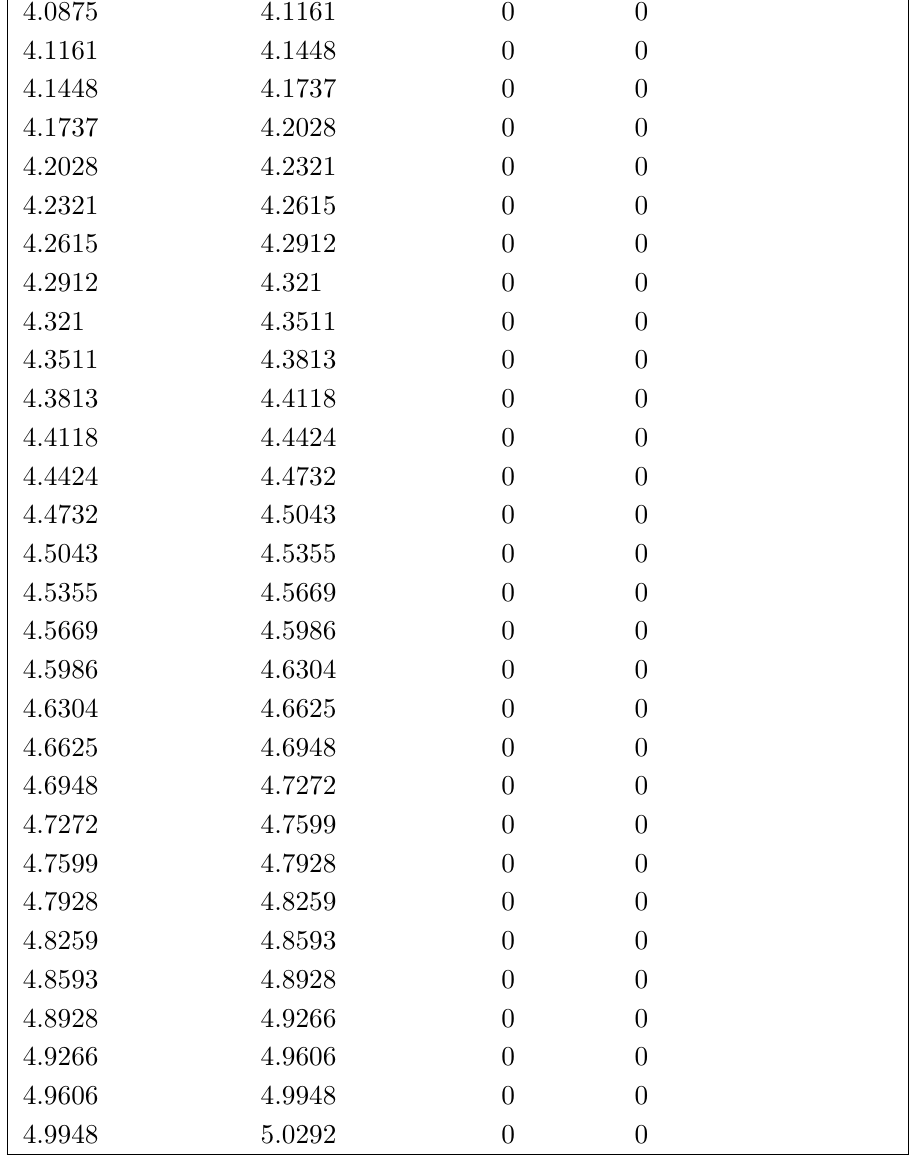
Table 10. Expected and observed event yields in the dielectron channel, directly corresponding to the non-linear binning presented in (cid:12)gure 3a. The expected yield is given up to at most 4 digit